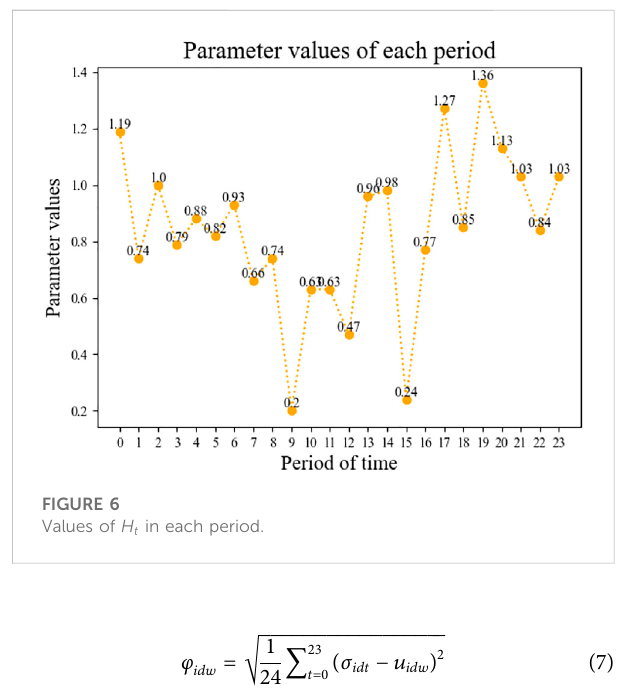
FIGURE 6 Values of H t in each